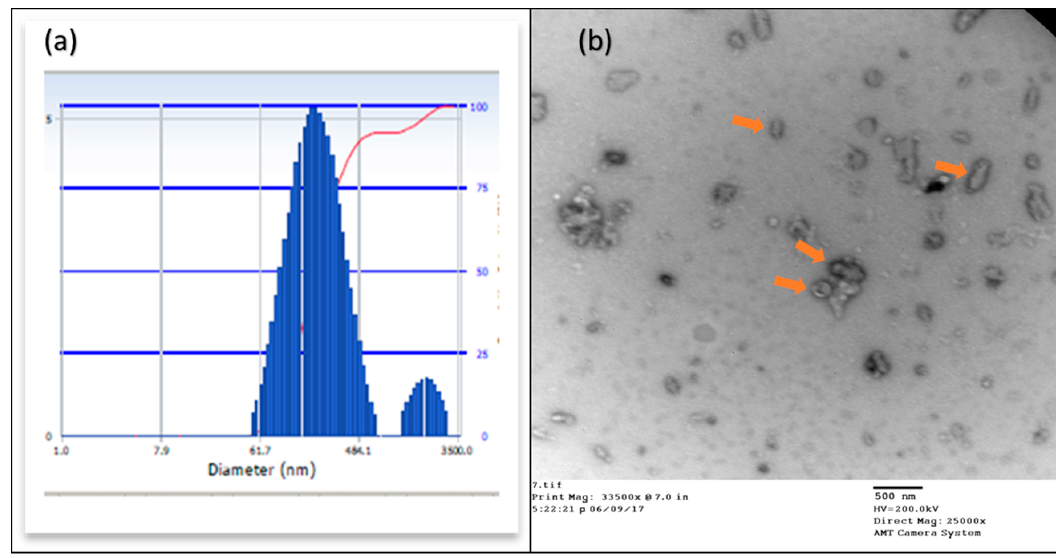
Figure 3. Scheme for the synthesis of the BSA-CDF-ATZ nanoparticle using click chemistry. This scheme illustrates the steps involved in the synthesis of the a theranostic nanoparticle guided by CA IX for cell killing in